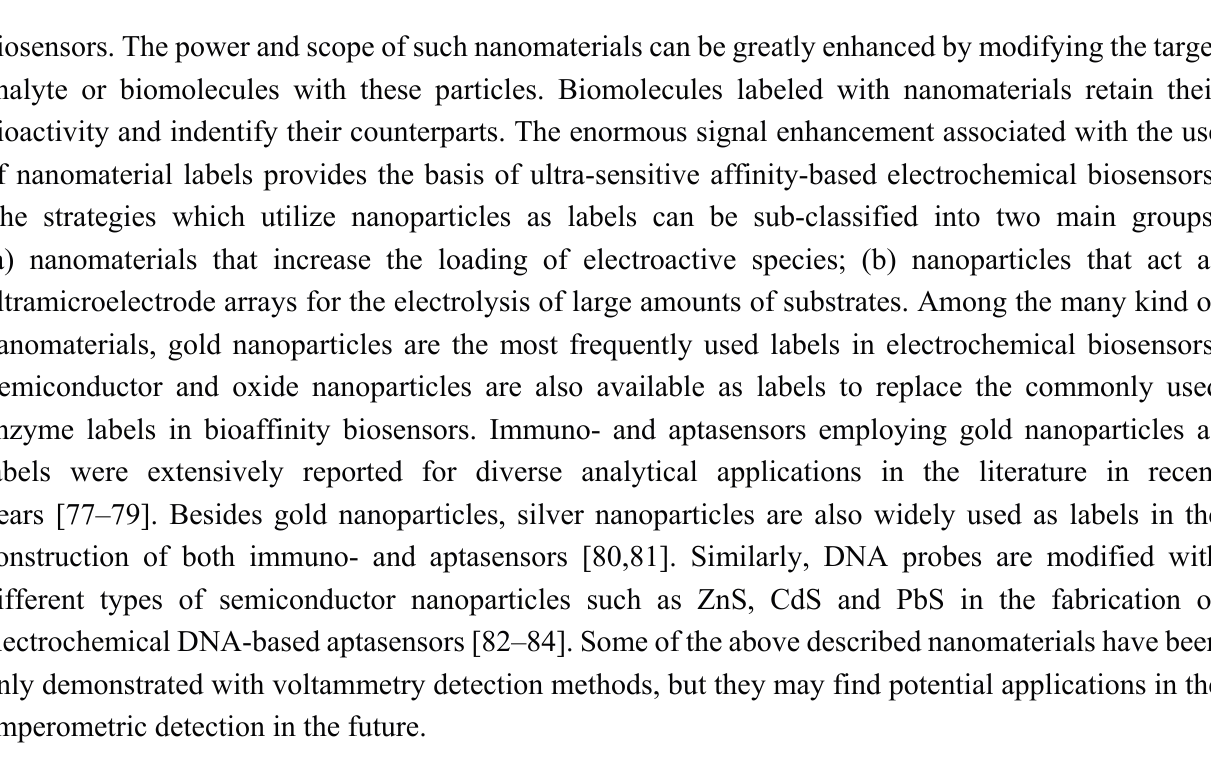
Figure 4. Nanomaterials as labels: ( A ) Direct assays; ( B ) Sandwich type